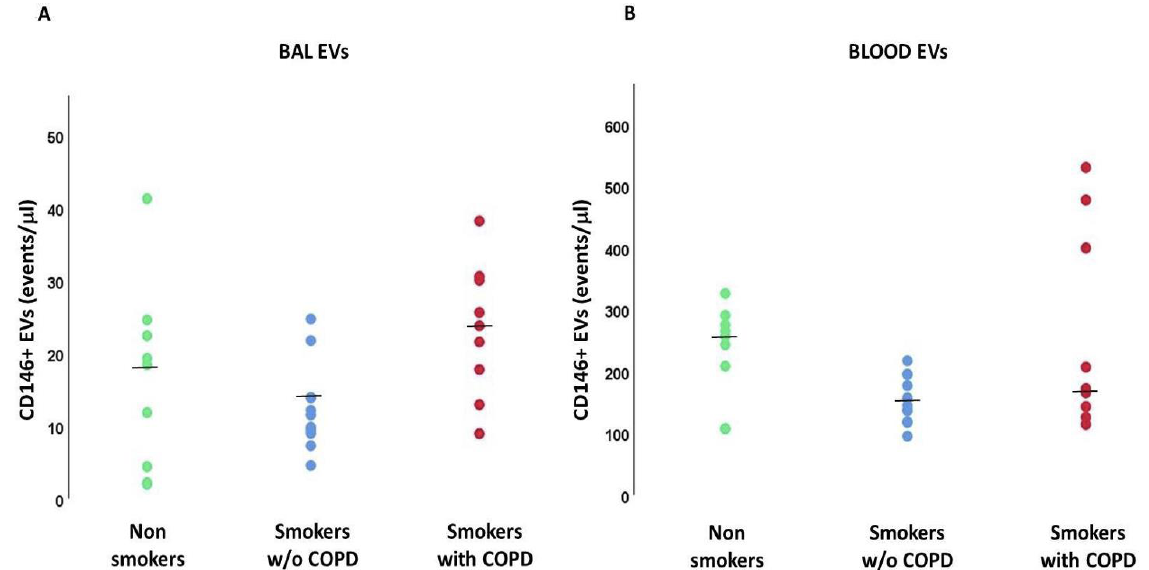
Figure 3. Endothelial-derived EVs (CD146+ events/μ L) in BAL ( A ) and Blood ( B ). p values in the figure represent the results of Mann-Whitney U tests. Kruskal-Wallis test: p < 0.001 for BAL EVs. Kruskal-Wallis test: p = NS for Blood EVs.